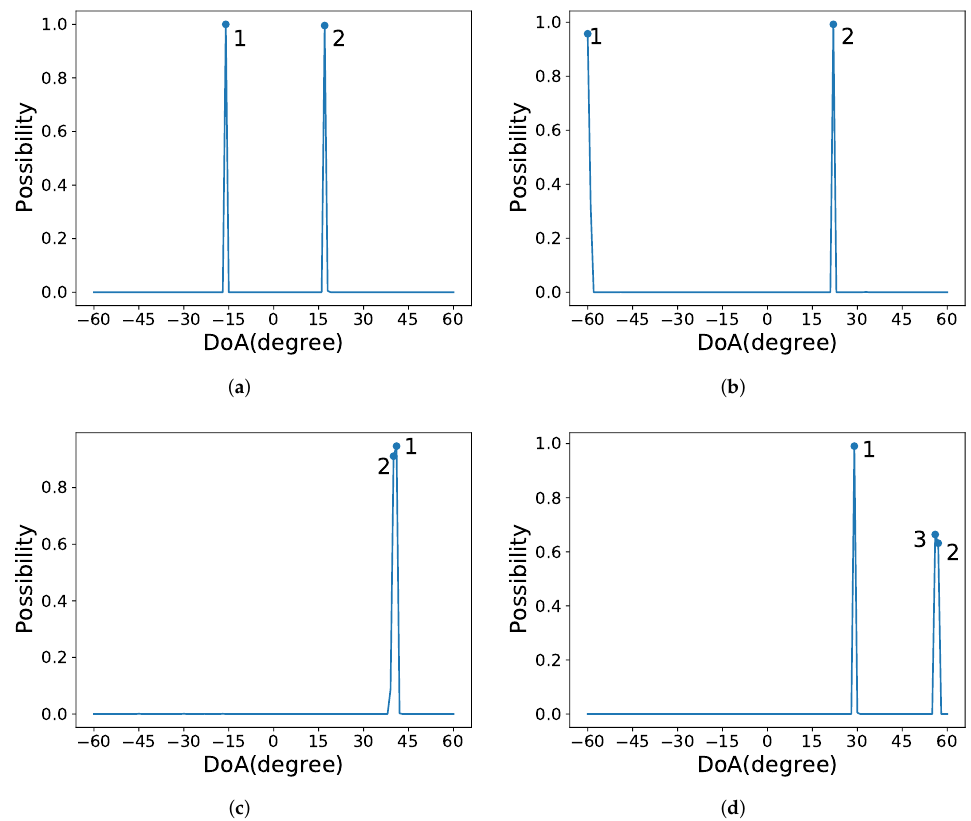
Figure 2. The results of the C-Branch. The true directions of ( a – d ) are ( − 16.15 ◦ , 17.27 ◦ ), ( − 59.92 ◦ , 21.92 ◦ ), (40.29 ◦ , 40.56 ◦ ), and (29.15 ◦ , 56.47 ◦ ),